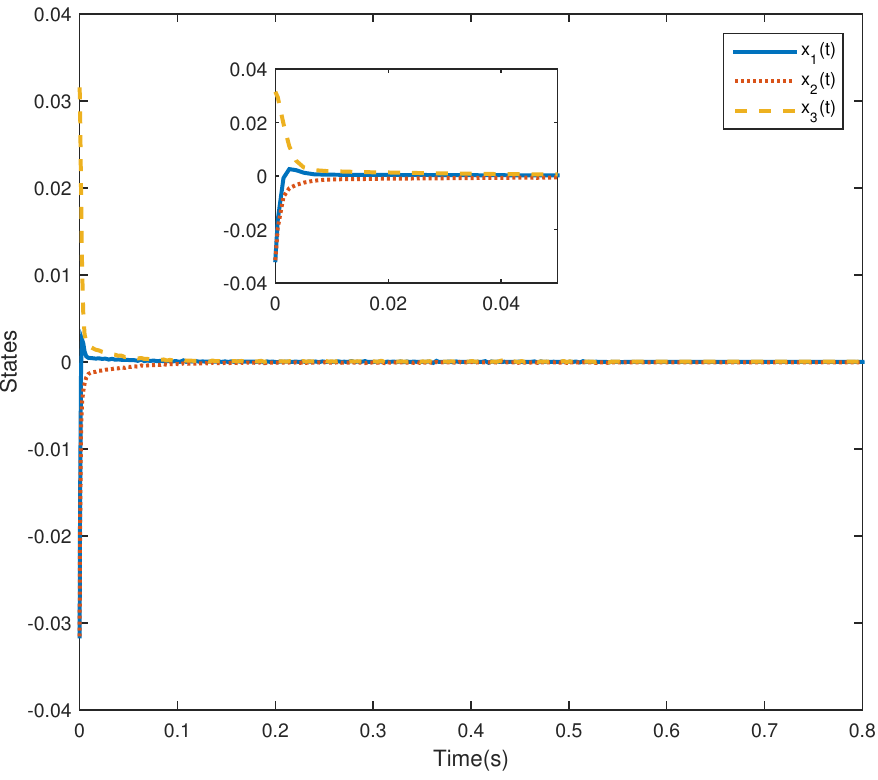
Figure 3. The closed-loop FOS in Example 2. For FOIS (2) with order α = 1.2, the simulation result of Example 2 with the initial condition x ( 0 ) = [ − 0.01 − 0.01 0.01 ] T ∈ B ε is depicted in Figure 4. System (2) is stabilized through the state feedback controller in about 0.4 s.